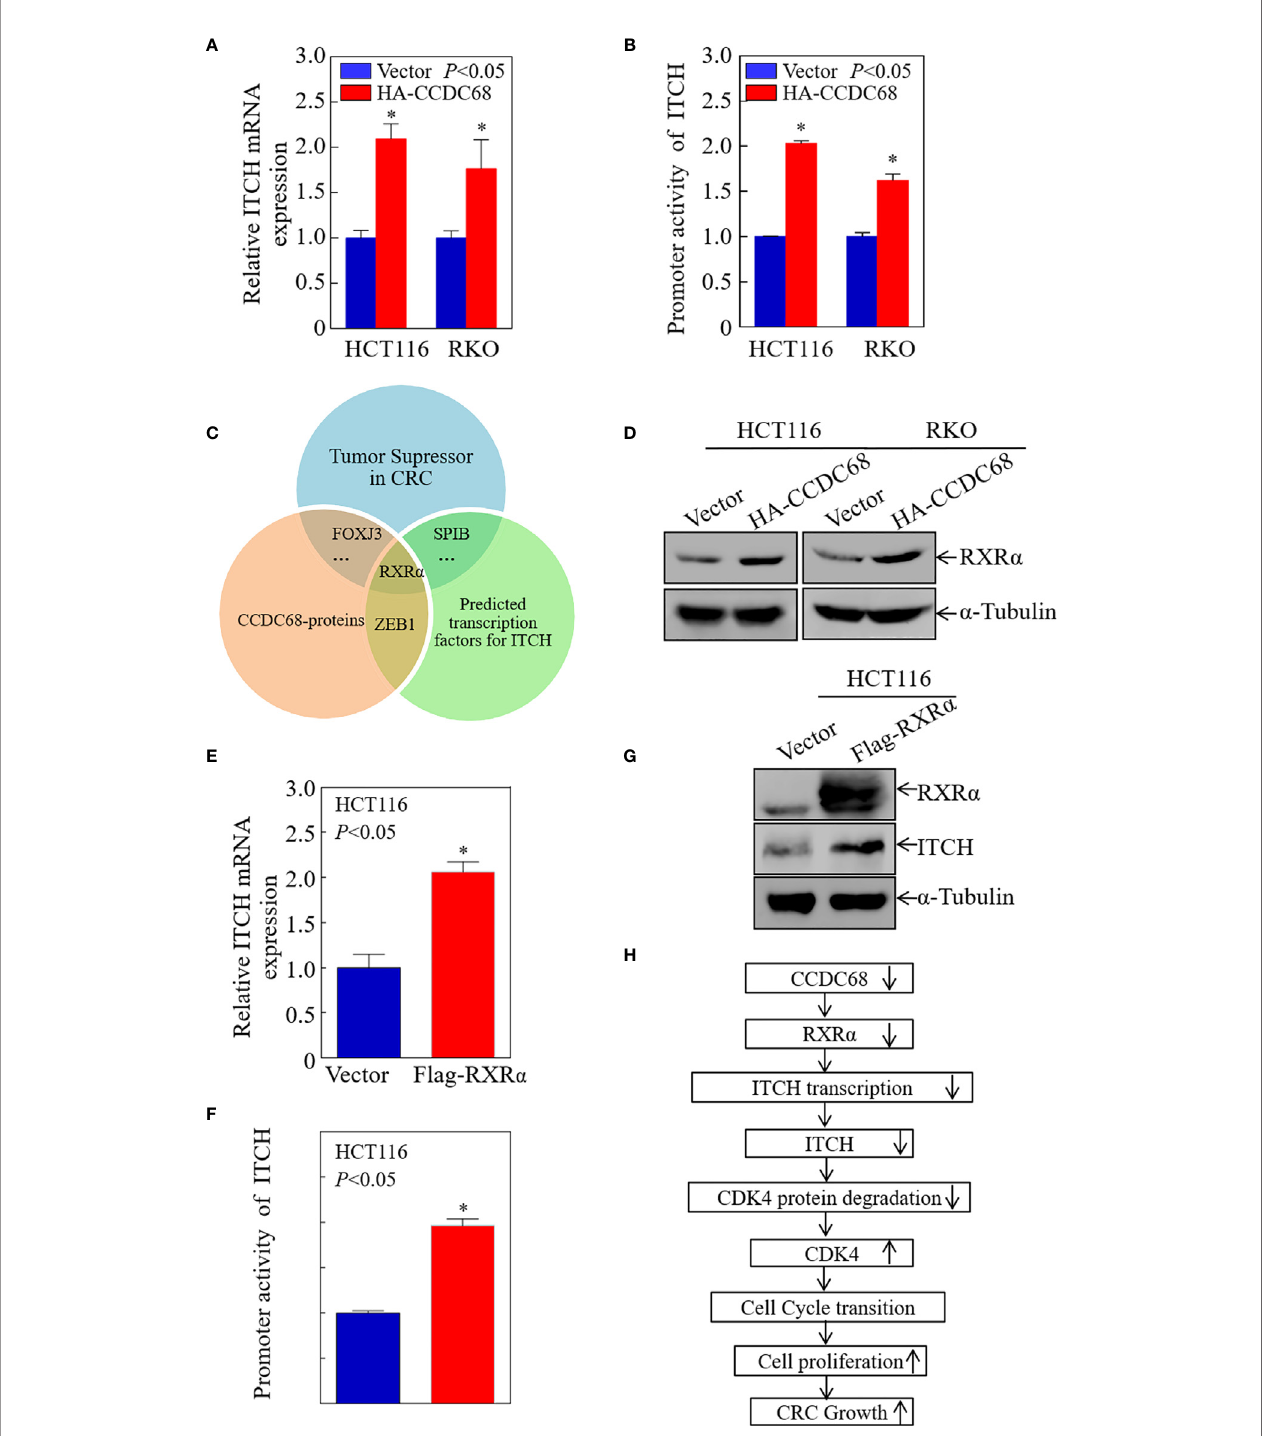
FIGURE 7 | CCDC68 promotes ITCH transcription by upregulating RXR a expression. (A) CCDC68 overexpression increased the mRNA levels of ITCH. (B) ITCH promoter activity in CCDC68 overexpression cells compared with vector control cells. (C) Bioinformatics and proteomics analysis of transcription factors potentially involved in the regulation of ITCH transcription. (D) RXR a expression levels in HCT116 (Vector/HA-CCDC68) and RKO (Vector/HA-CCDC68) cells. (E) ITCH mRNA levels in HCT116(RXR a ) and HCT116(Vector) cells. (F) ITCH promoter activity in HCT116 (RXR a ) and HCT116 (Vector) cells. (G) Expression levels of ITCH in HCT116 (RXR a ) and HCT116 (Vector) cells. (H) Schematic diagram of the molecular mechanism underlying the effect of CCDC68 on regulating the proliferation of colorectal cancer cells. Data are presented as the mean ± SD and analyzed by Student ′ s t -test. *P <